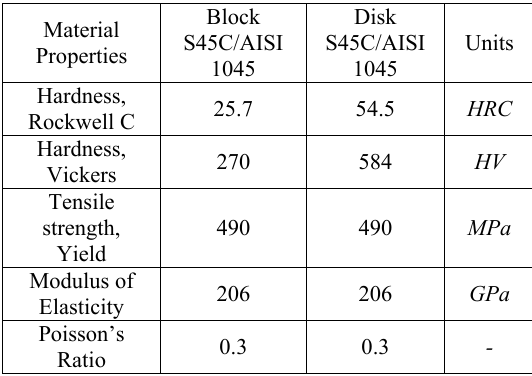
Table 1. The properties of the test materials